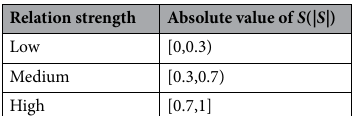
Table 6. The relation strengths of trend similarities among